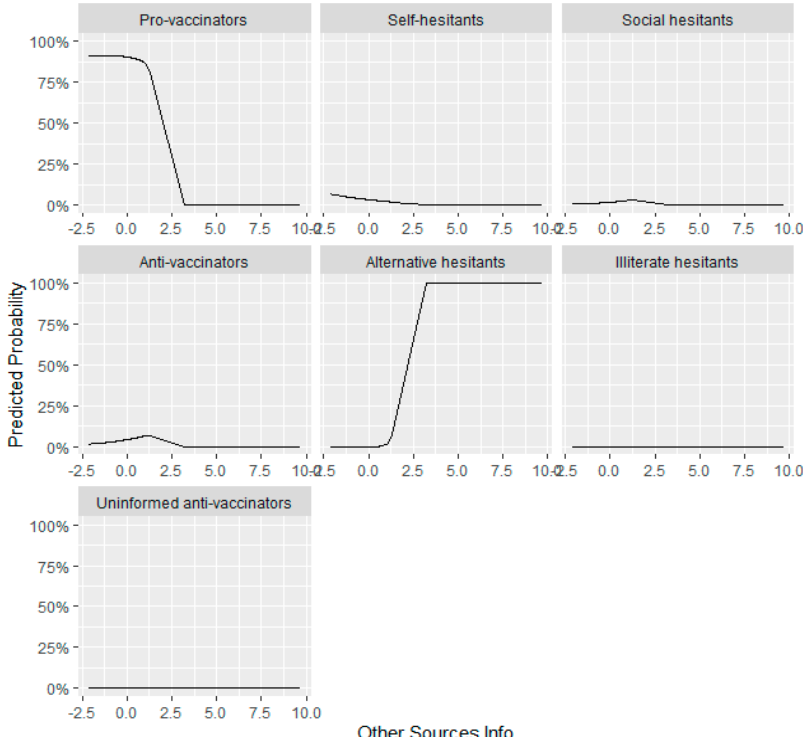
Figure A13. Marginal Effects Multinomial Logistic Regression. Other Sources Info.